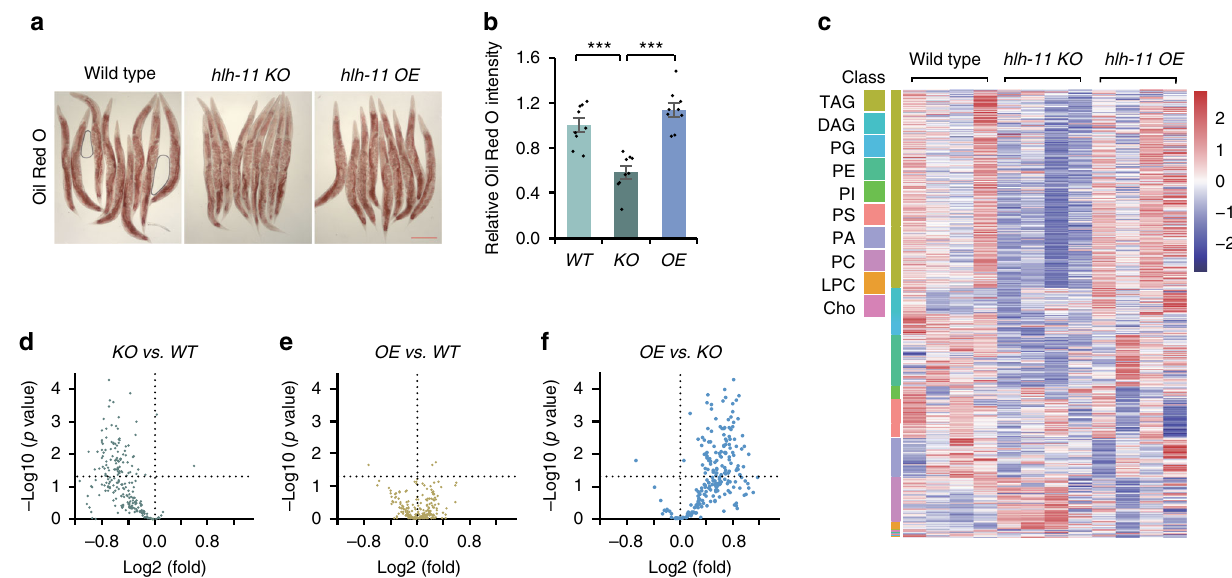
Fig. 4 Knockout of HLH-11 affects lipid storage. a Oil Red O staining of wild-type, hlh-11 KO, and hlh-11 OE worms (day 1 adult). Three independent experiments were performed with similar results. Scale bar, 200 μ m. b Quanti fi cation of Oil Red O signals from the upper intestine in a . n = 9 worms examined per condition. Error bars indicate mean ± SEM. Statistical analyses were performed by Student ’ s t test (unpaired, two tailed), *** p = 9.5E − 5 (KO vs WT), *** p = 3.0E − 6 (OE vs KO). c Heat map showing the levels of lipids detected by mass spectrometry in wild-type, hlh-11 KO, and hlh-11 OE worms. TAG triacylglycerols, DAG diacylglycerols, PG phosphatidylglycerols, PE phosphatidylethanolamines, PI phosphatidylinositols, PS phosphatidylserines, PA phosphatidic acids, PC phosphatidylcholines, LPC lyso-phosphatidylcholines, Cho free cholesterols. d – f Volcano plots showing fold changes of lipids in the TAG categories. d hlh-11 KO compared with wild-type animals; e hlh-11 OE compared with wild-type animals; f hlh-11 OE compared with hlh-11 KO. p values are calculated using one-sided Tukey ’ s HSD test. Horizontal dashed line indicates p = 0.05. Source data are provided as a Source data fi